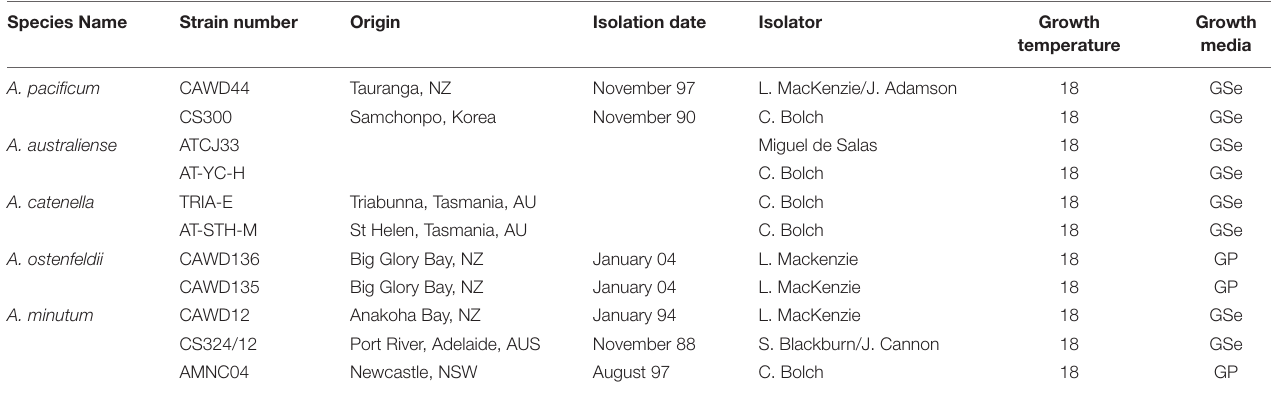
TABLE 1 | Cultures used for this